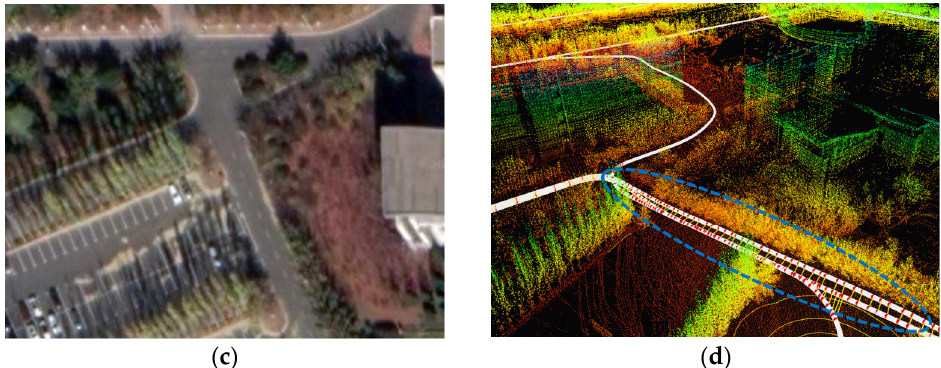
Figure 13. Effectiveness of the algorithm on reverse loop closures. ( a , c ) are the aerial photos of these segments of data; ( b , d ) are the effects of reverse loop closure detection by the 3PCD-TP algorithm over these two segments of data. The loop closure we mark with blue dashed line, and the yellow connecting line represents the loop closure constraint.